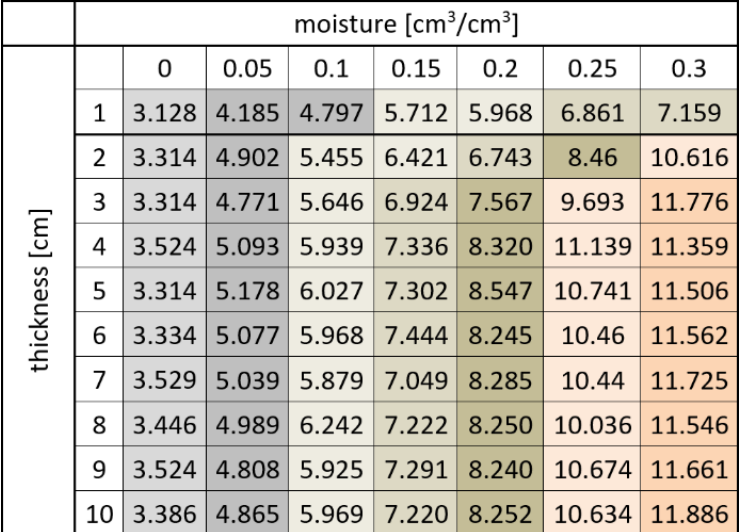
Figure 10. Post hoc analysis of apparent permittivity readouts using sensor A for various values of sample moistures and sample thicknesses. Each color means different homogenous group.